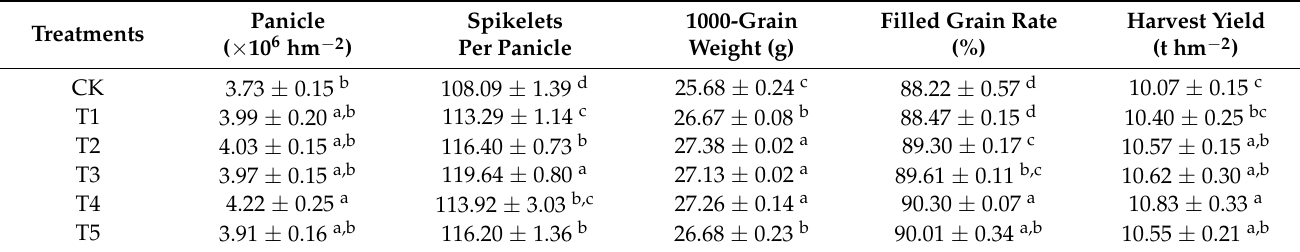
Table 1. Rice yield and its components under different ZnO NPs application amounts.